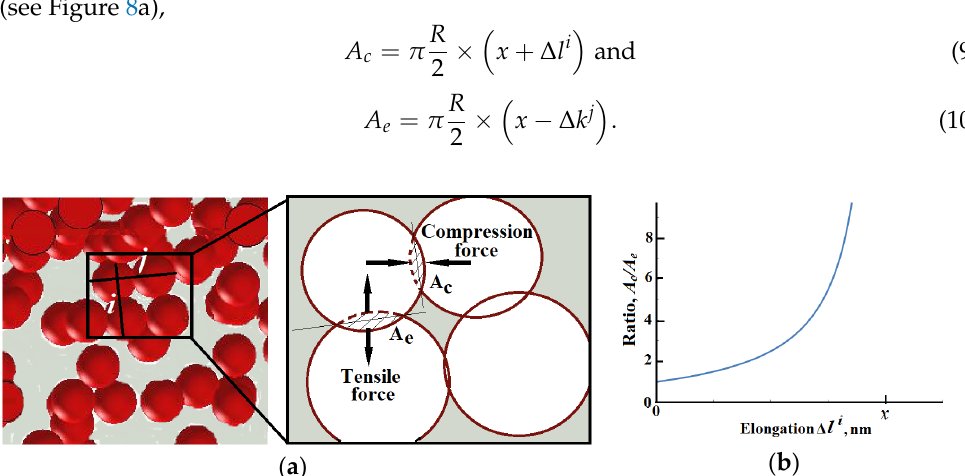
Figure 8. ( a ) Scheme of contact areas conductivity model; ( b ) Ratio between parallel and perpendicular contact area vs. interparticle displacement in tensile direction.